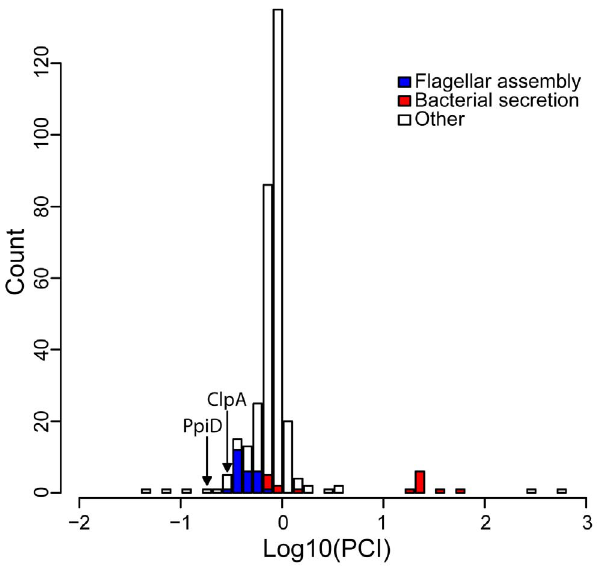
Figure 3. The distribution of the Putative Client Index, PCI , among hsp90A -associated genes. Lower values indicate behavior closer to that expected of a client. The 18 genes most likely to be clients are listed in Table 2. Prominent functional groups are highlighted, as well as two chaperone-encoding genes.